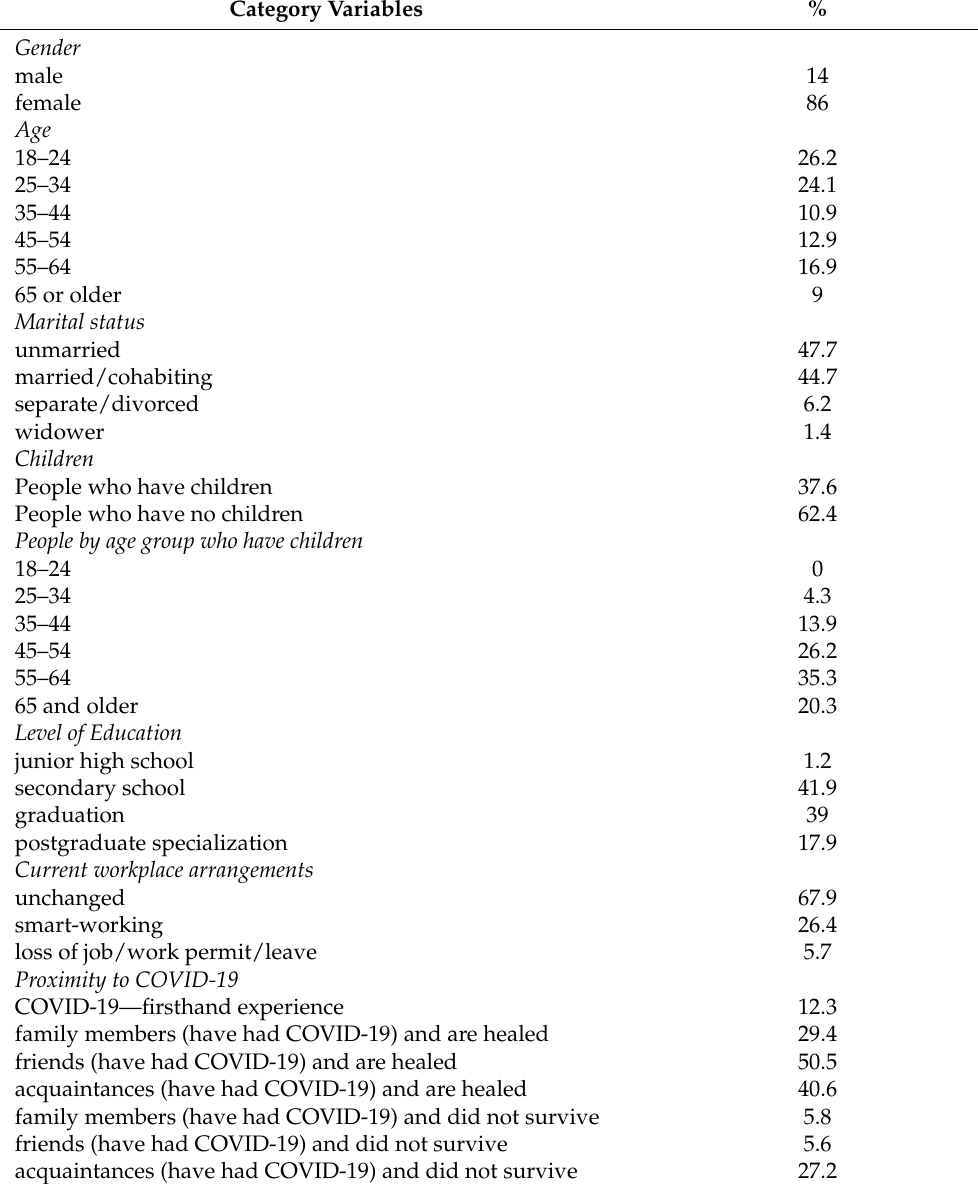
Table 2. Sociodemographic characteristics of the participants (N = 500). Category